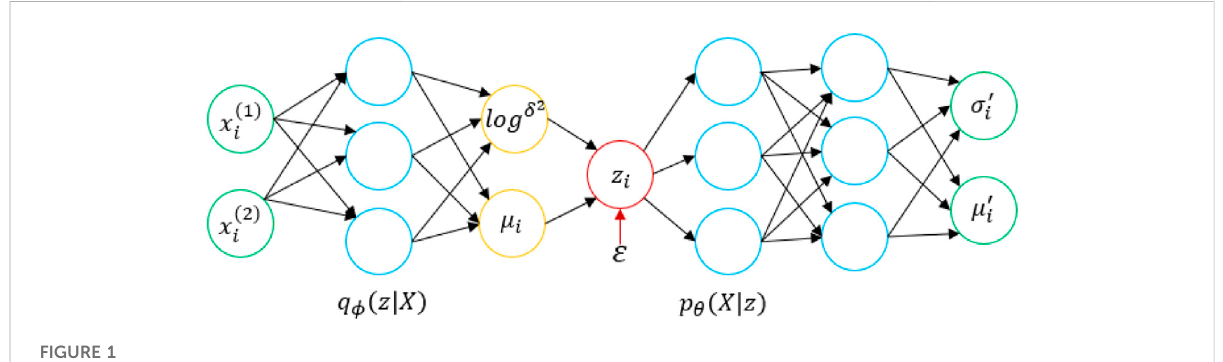
FIGURE 1 Structural diagram of the utilized VAE.